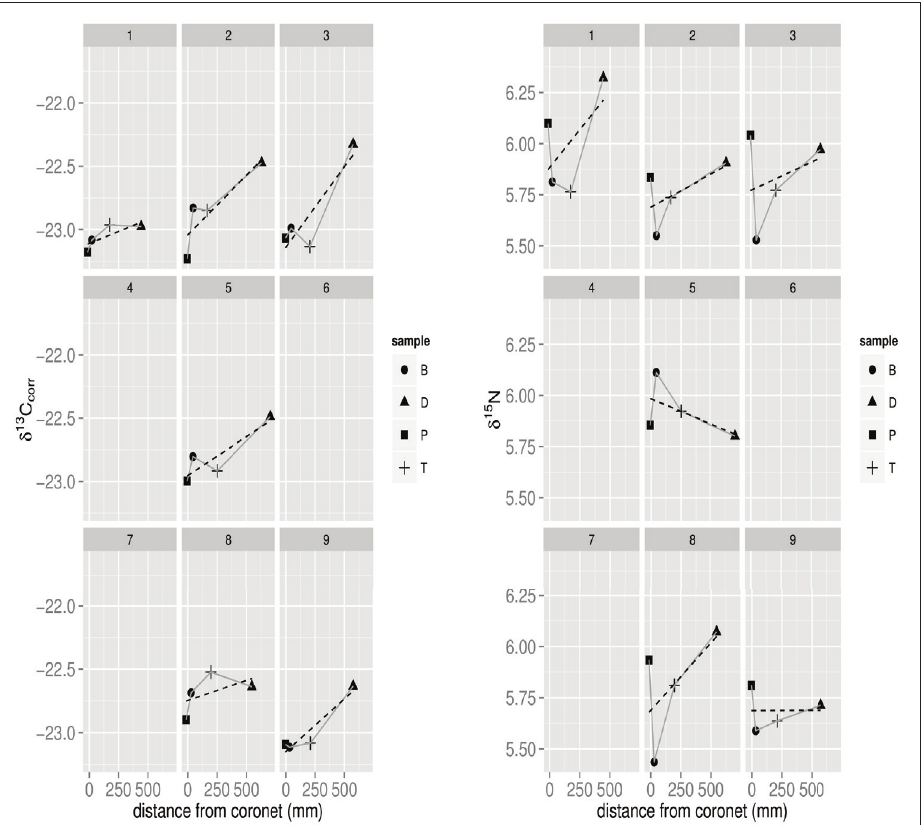
Figure 4: Variation of δ 13 C and δ 15 N along length of antler. Path representing antler between sample points shown as grey line; linear regression line of best fit shown as dashed